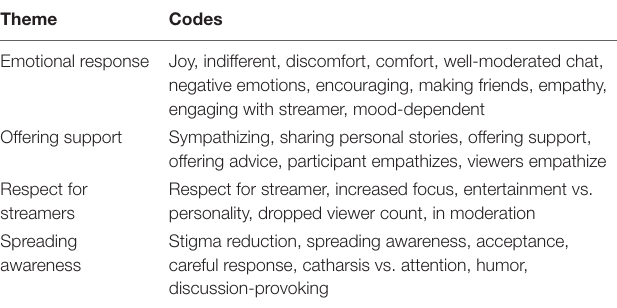
TABLE 4 | Coding breakdown for RQ3: viewer reaction to mental health in the gaming community. Theme